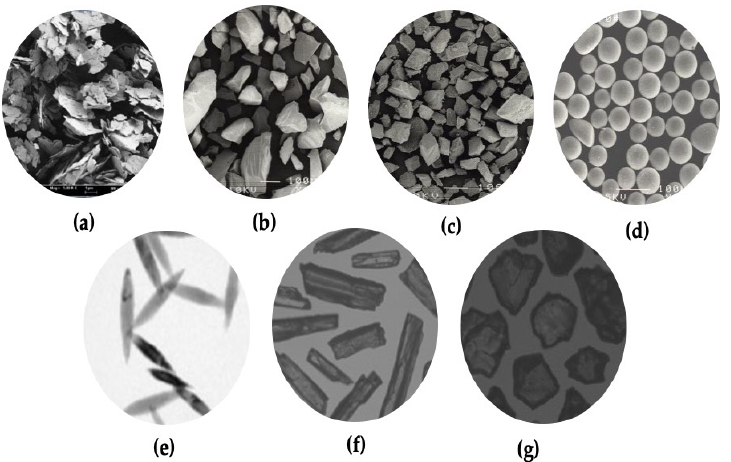
Figure 11. Particle shape characteristics of some mineral particles: ( a ) platy talc particles; ( b ) angular quartz particles; ( c ) irregular barite particles; ( d ) glass beads; ( e ) cigar-shaped particles [59]; ( f ) rod-shaped wollastonite particles; ( g ) equant quartz particles.